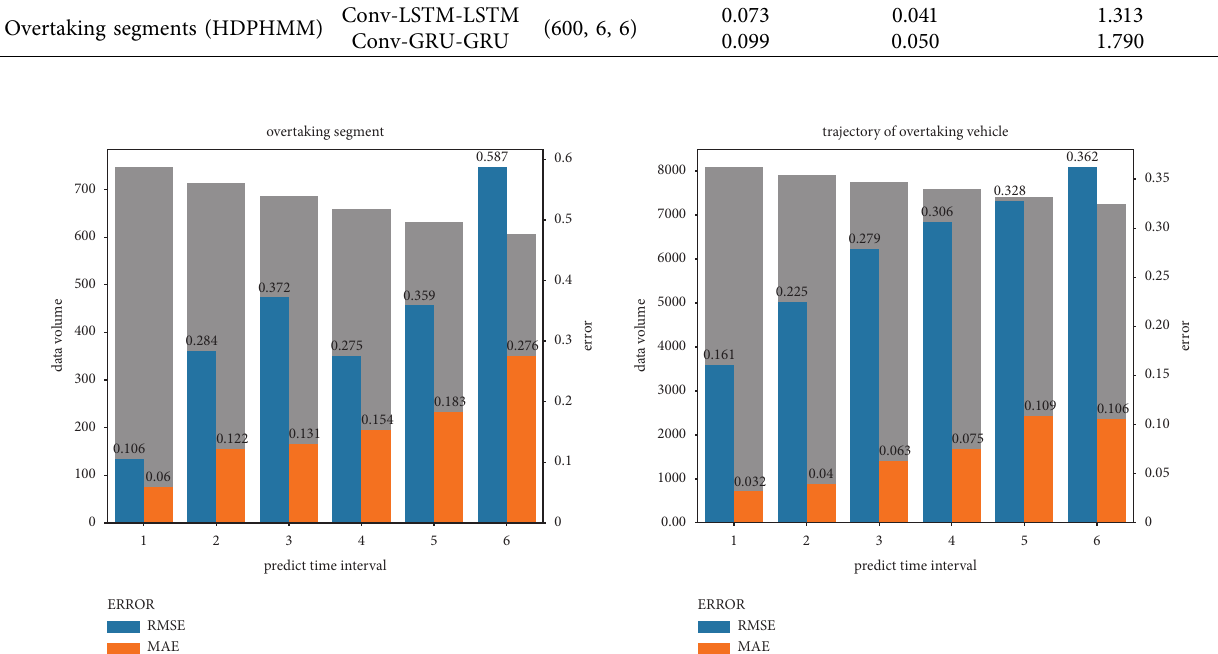
Figure 18: Model errors under different prediction time